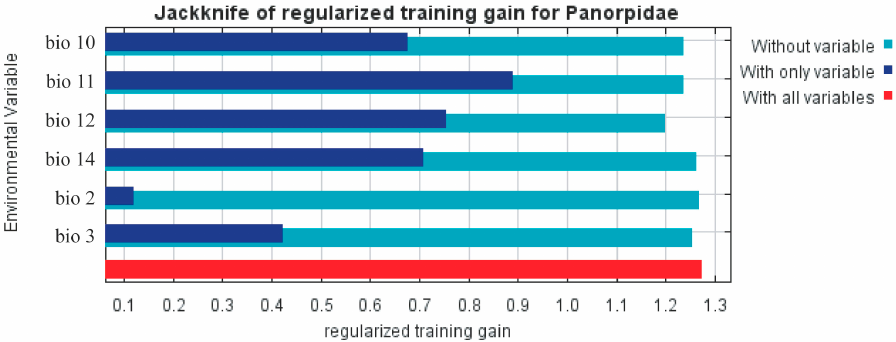
Figure 3. Panorpidae distribution using the jackknife test: significance of key environmental factors. Figure 4 shows the response curves for the six bioclimatic variables obtained from the MaxEnt model.